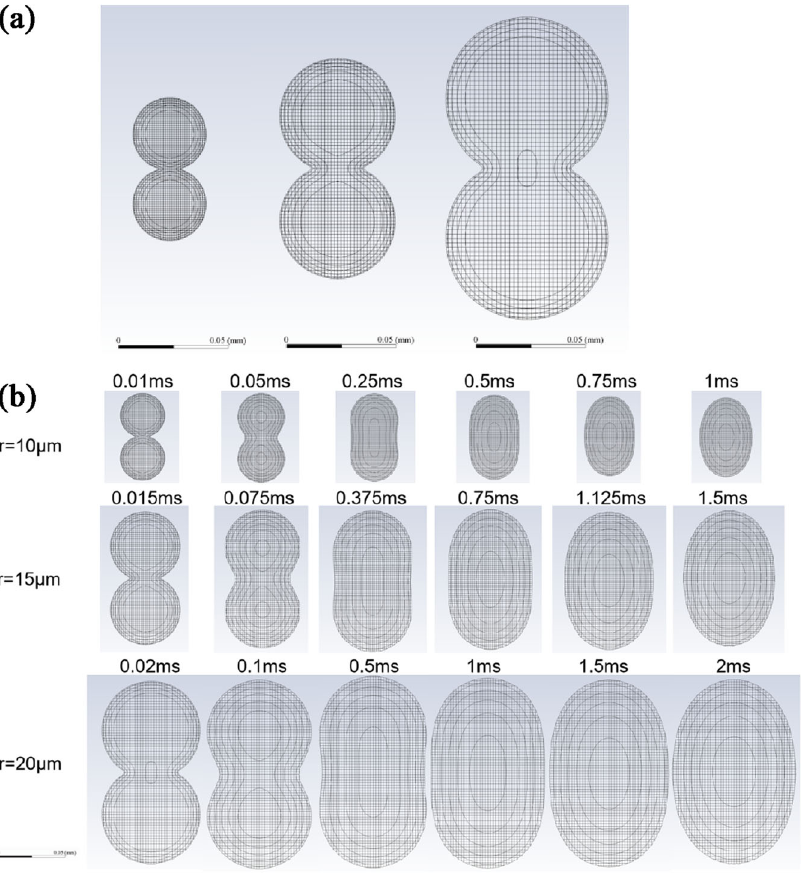
Fig. 5 In fl uence of droplet size in simulation. a Simulated morphology of three cases with the same measuring scale. b Simulated morphology of three cases at different calculation times. a shows the scale difference of droplets and meshes in three cases with the same measuring scale. b Shows the simulated morphology of these cases, but the time is chosen by the same proportion of their scale. Results verify that it takes more time for larger droplets to form a certain